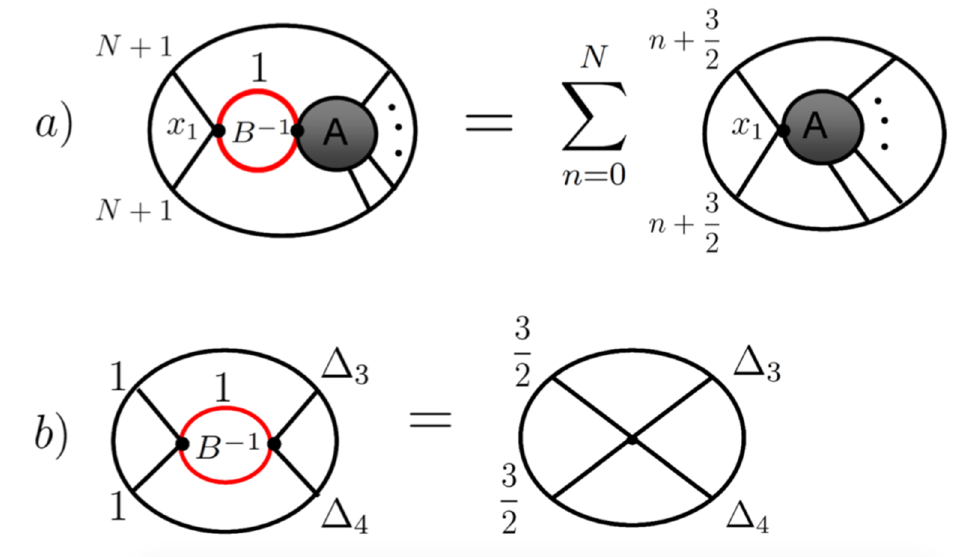
Figure 13 . a) Identity 9’: reduces the resummed bubble diagrams with (cid:1) = 1. The red loop is notation for the resummed bubble with scaling dimension (cid:1) = 1, given on the right hand side of eq. (4.11). b) Applying Identity 9 immediately gives the result for the 4-point function in the conformal large- N O ( N ) model on AdS 3 , in terms of the contact diagram on the right. (cid:1) 3 and (cid:1) 4 are arbitrary in this diagram. The grey blob is general, numerical coe(cid:14)cients are suppressed, and the diagrams correspond to stripped correlators.